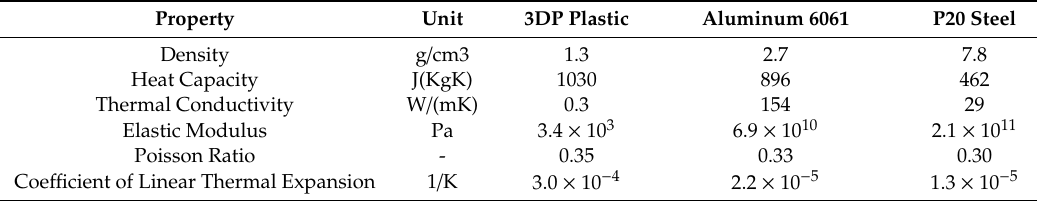
Table 7. Main properties of the di ff erent mold materials used for